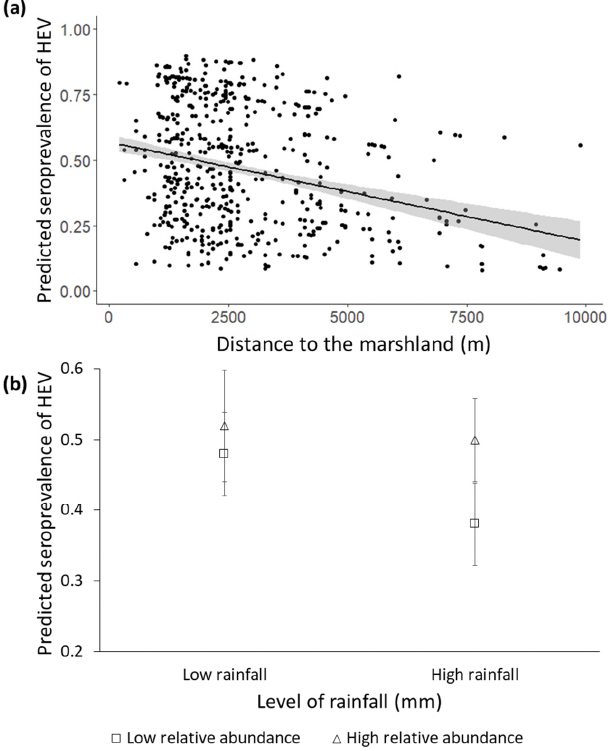
Figure 3. ( a ) Individual predicted probability to test positive for anti-HEV antibodies ( ± confidence interval (C.I.) 95%, represented by the shaded band) obtained from selected generalised linear mixed models (GzLMMs) depending on the distance to the marshland (metres). ( b ) Mean predicted probability to test positive for anti-HEV antibodies ( ± standard error (S.E.) 95%, represented by the error bars) obtained from selected GzLMMs depending on the interaction between annual rainfall (millimetres) and the relative abundance of wild boar (KAI). The following categories were established to display results: low rainfall ( ≤ 521.10 mm), high rainfall (>521.10 mm), low relative abundance of wild boar ( ≤ 0.69 KAI) and high relative abundance of wild boar (>0.69